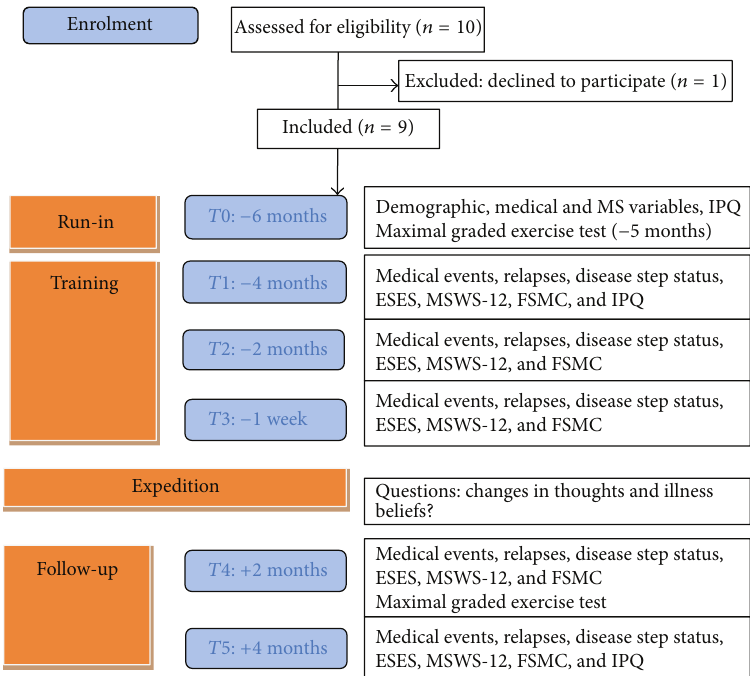
Figure 1: Enrolment, timeline, and assessments at different time